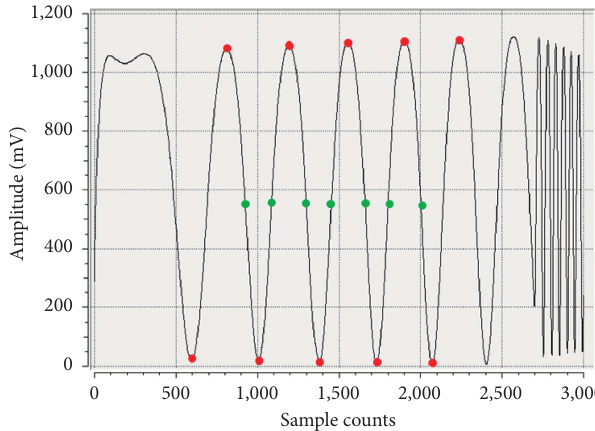
Figure 8: Zero-point determination of interference cosine signal.